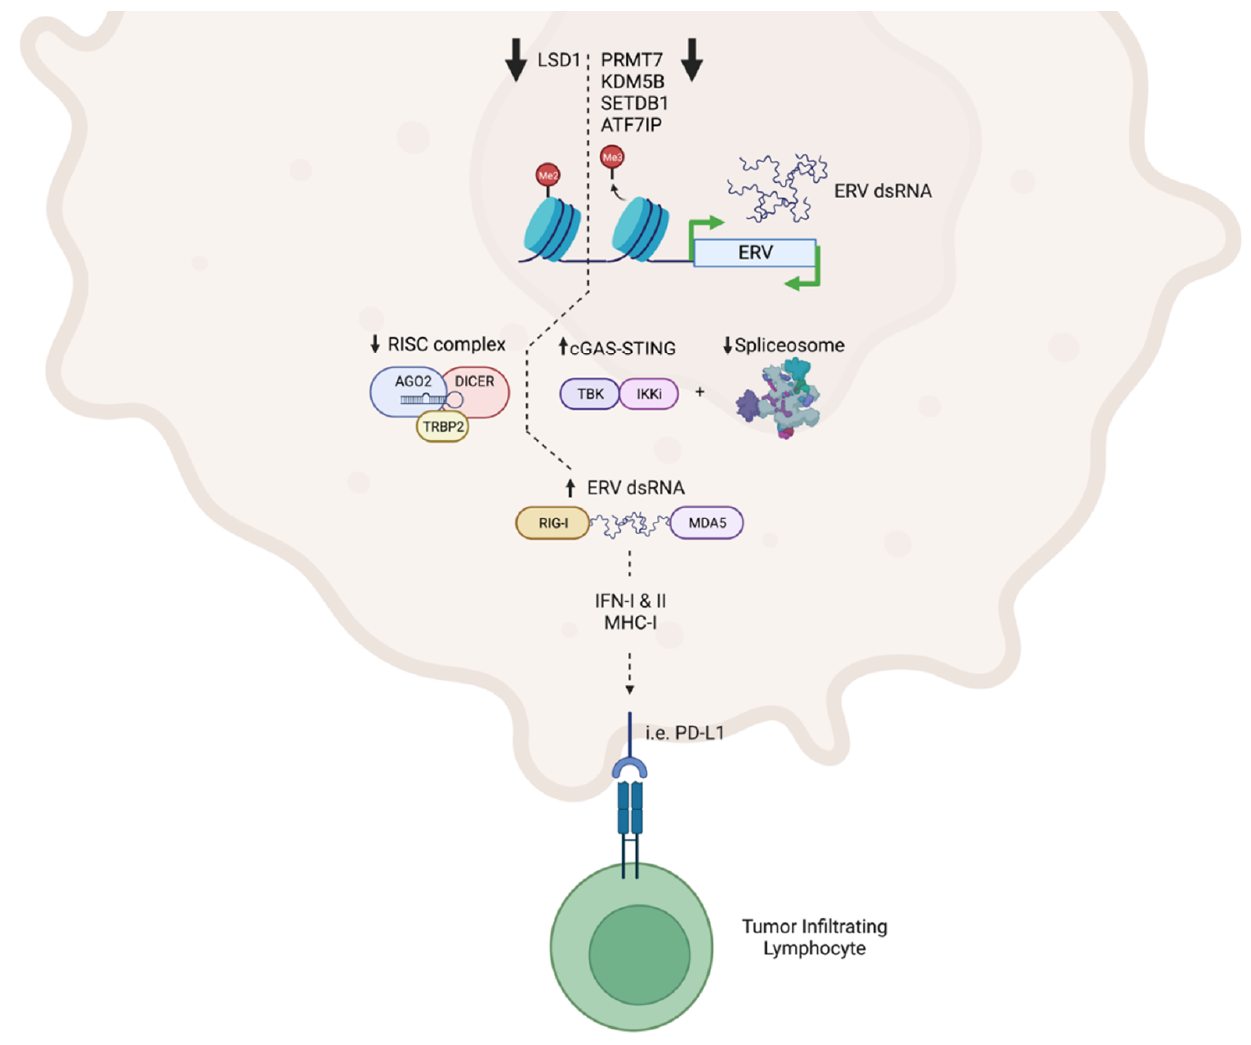
Figure 1. Viral mimicry by epigenetic regulators: A beneficial instance of cellular hypochondria. Epigenetic regulation of post-translational modifications by LSD1, PRMT7, KDM5B, ATF7IP, and SETDB1 modulates the expression of genomically integrated endogenous retroviral (ERV) elements and elicits interferon (IFN)-driven states that regulate anti-PD-1 and anti-CTLA-4 immunotherapy responses.